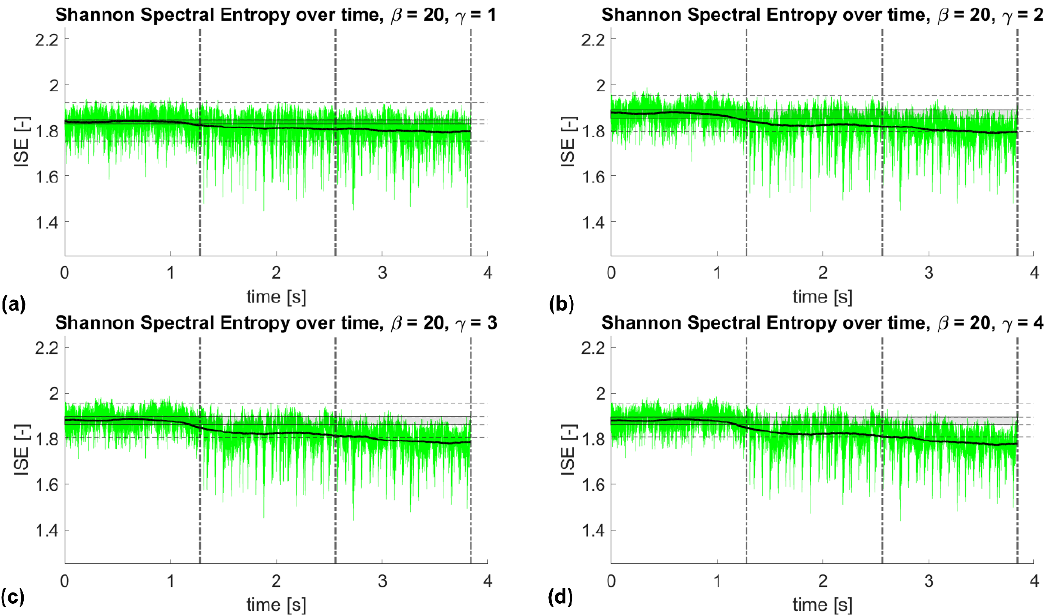
Figure 9. Resulting ISE (signal #1). Values for. 𝛽 = 20 and 𝛾 equal to ( a ) 1, ( b ) 2 , ( c ) 3 , and ( d ) 4.